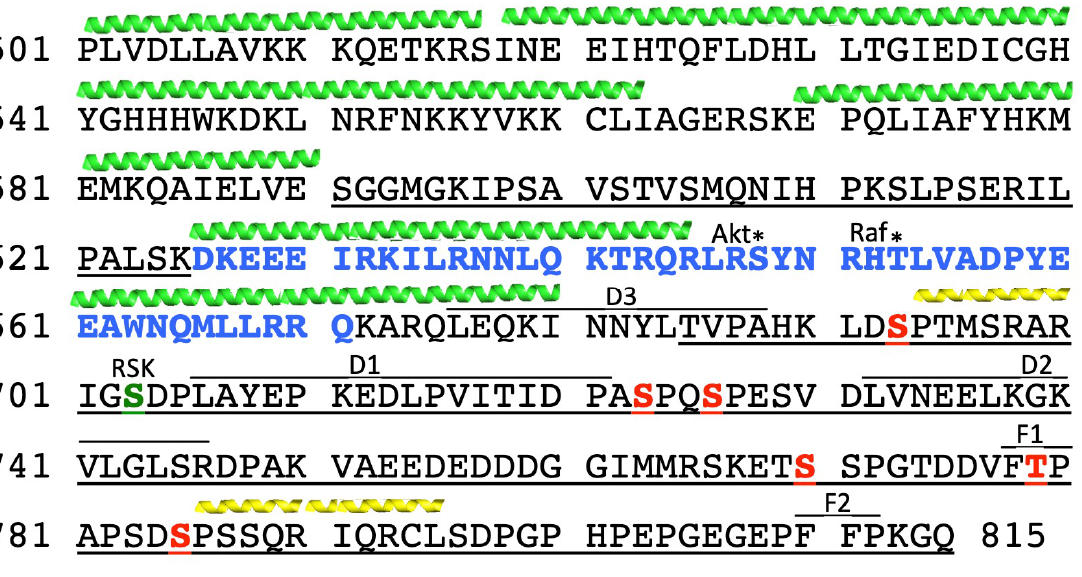
Figure 4. Amino acids of the cytosolic regulatory C-terminal domain of NHE1, with features indicated. Intrinsically disordered amino acids are underlined [34]. Amino acids phosphorylated by ERK and identified in the work of [142] are shown in red. Calmodulin binding domain, blue / bold. Ser 703 phosphorylated by p90 RSK , bold and green. Thr 653 , phosphorylation site of β -Raf, indicated by *. Ser 648 , AKT phosphorylation site, indicated by an asterisk. D-domain and F-site putative ERK binding sites [142] are indicated with a line over the amino acid. Green helices above amino acids are the approximate location of four predicted helices, according to the authors of [34]. Yellow helices above amino acids indicate transient helices induced by ERK-mediated phosphorylation, according to the authors of [145].